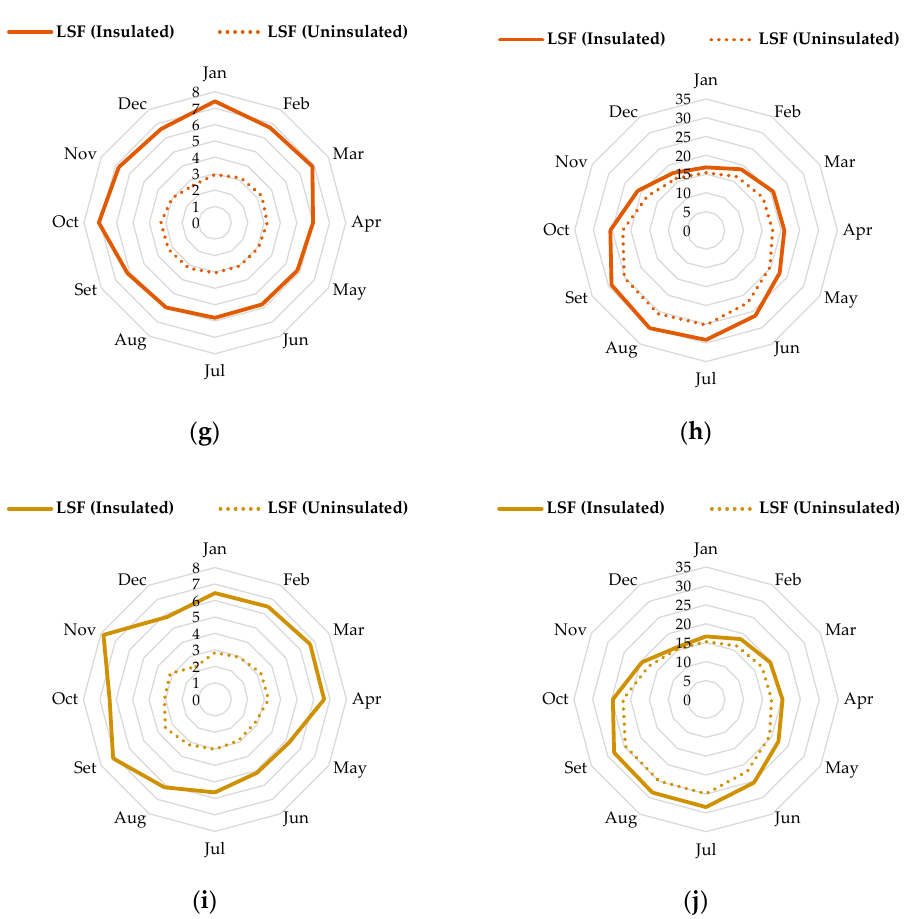
Figure 11. Monthly indoor air temperature amplitude and median values for the insulated and uninsulated setups obtained from dynamic simulations (°C): ( a , b ) Aveiro; ( c , d ) Bragança; ( e , f ) Évora; ( g , h ) Faro; ( i , j ) Lisboa.